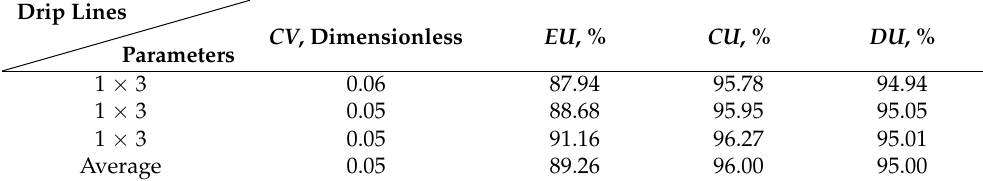
Table 3. Evaluation of drip irrigation system at an operating pressure head of one bar for the GR